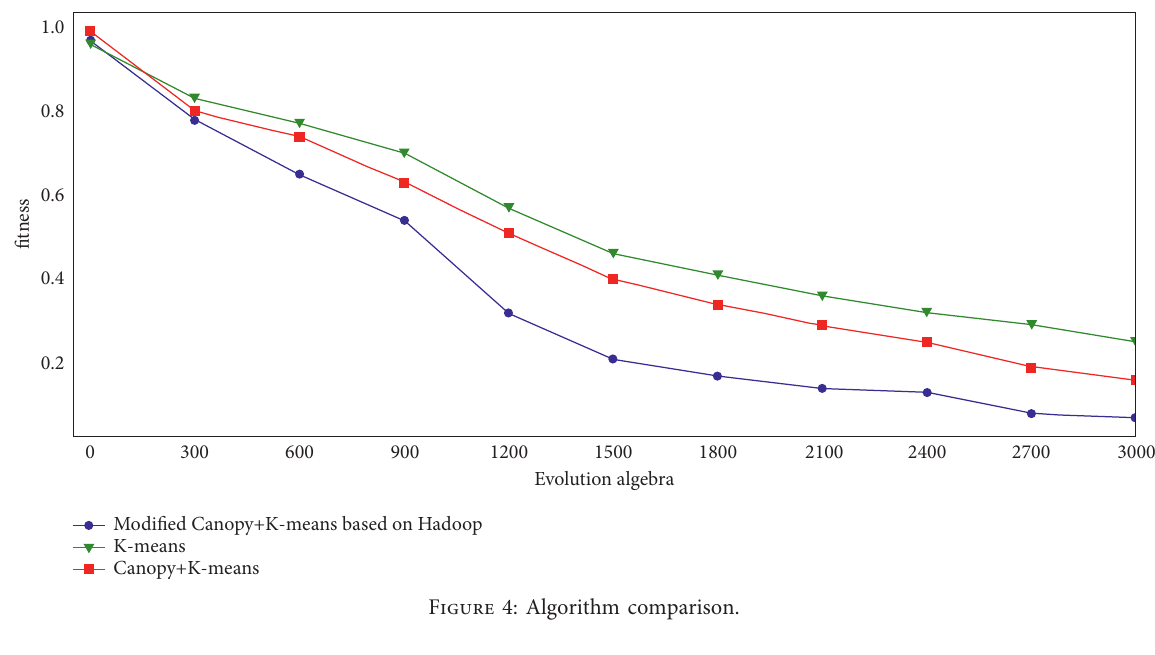
Figure 4: Algorithm comparison.